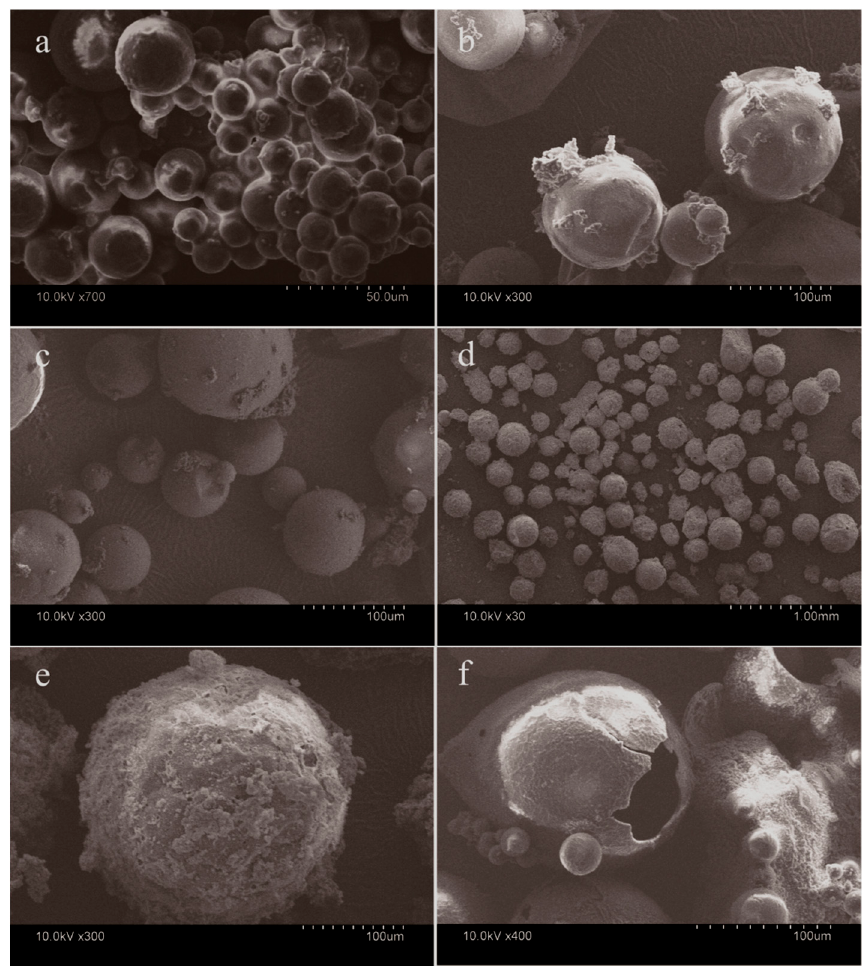
Figure 3. Scanning electron microscopy (SEM) morphologies of microcapsules with various graphene contents, ( a ) MG-0; ( b ) MG-2; ( c ) MG-4; ( d ) MG-6; ( e ) MG-8, and ( f ) a typical microcapsule with a broken shell. Nanomaterials 2018 , 8 , x FOR PEER REVIEW 10 of 21